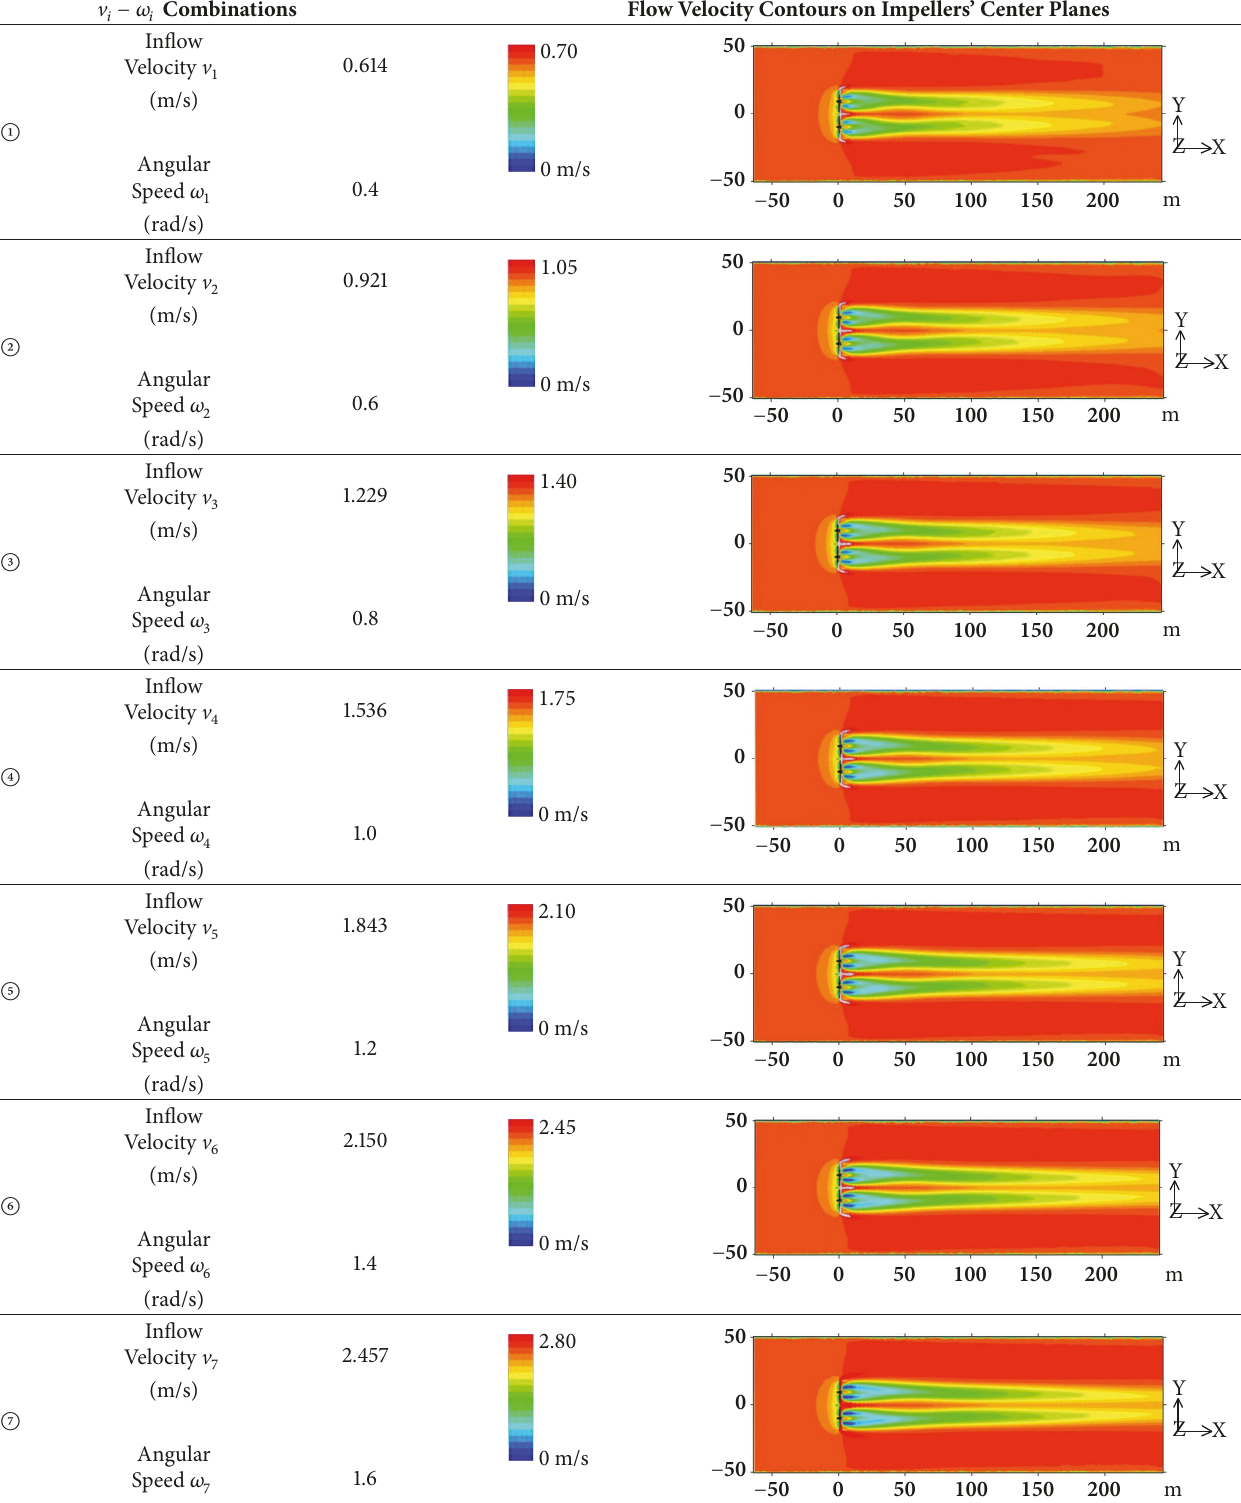
Table 2: Velocity distributions on impellers’ center planes in different combinations. V − 𝜔 𝑖 𝑖 Combination